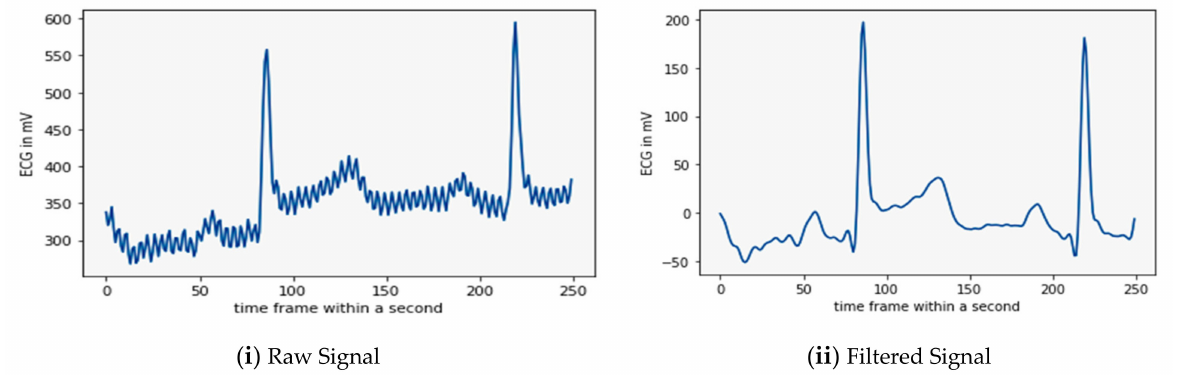
Figure 8. Illustration of sample raw and filtered signal from real-time